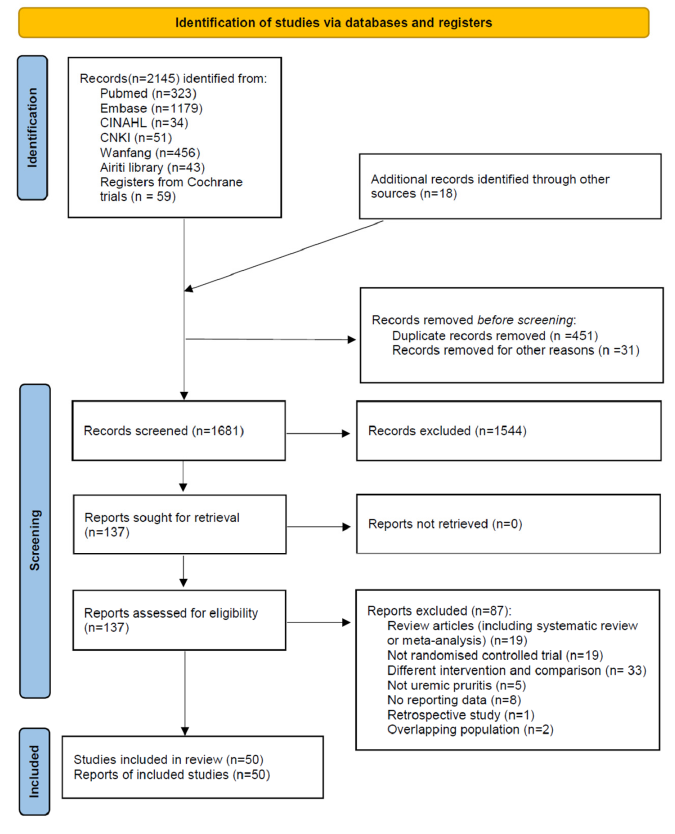
Figure 1. PRISMA 2020 flow diagram.